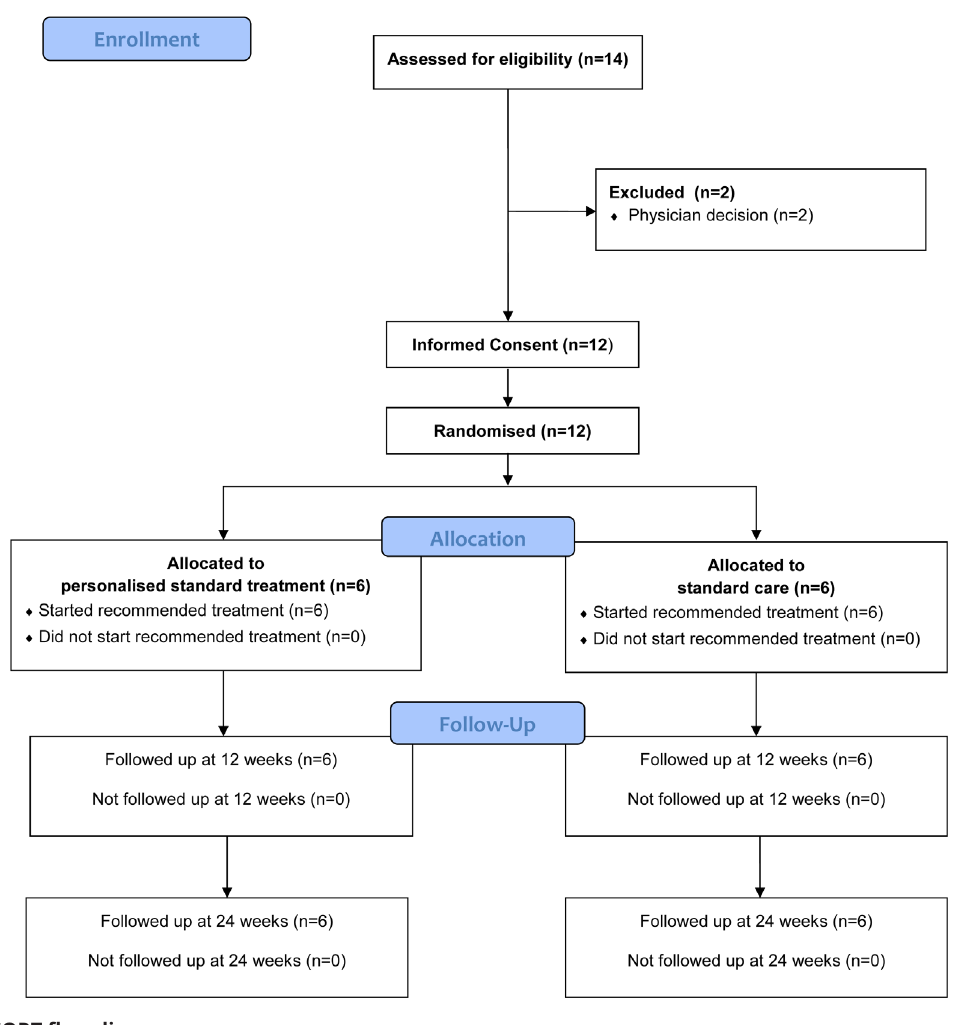
Figure 1. CONSORT flow diagram.